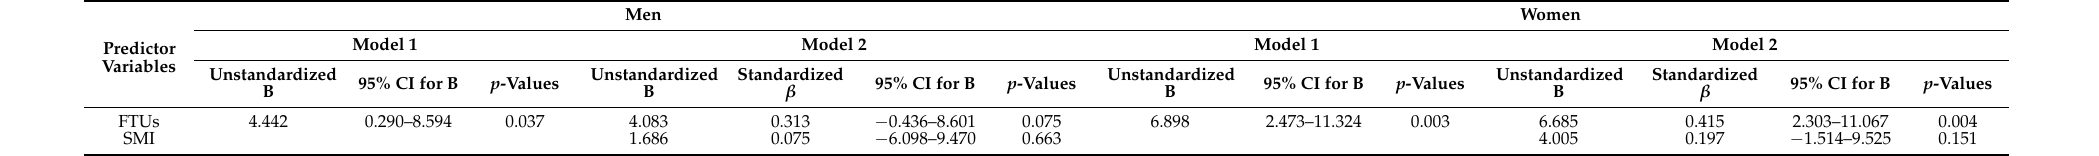
Table 5. Factors associated with mixing ability index by dividing into subgroups according to